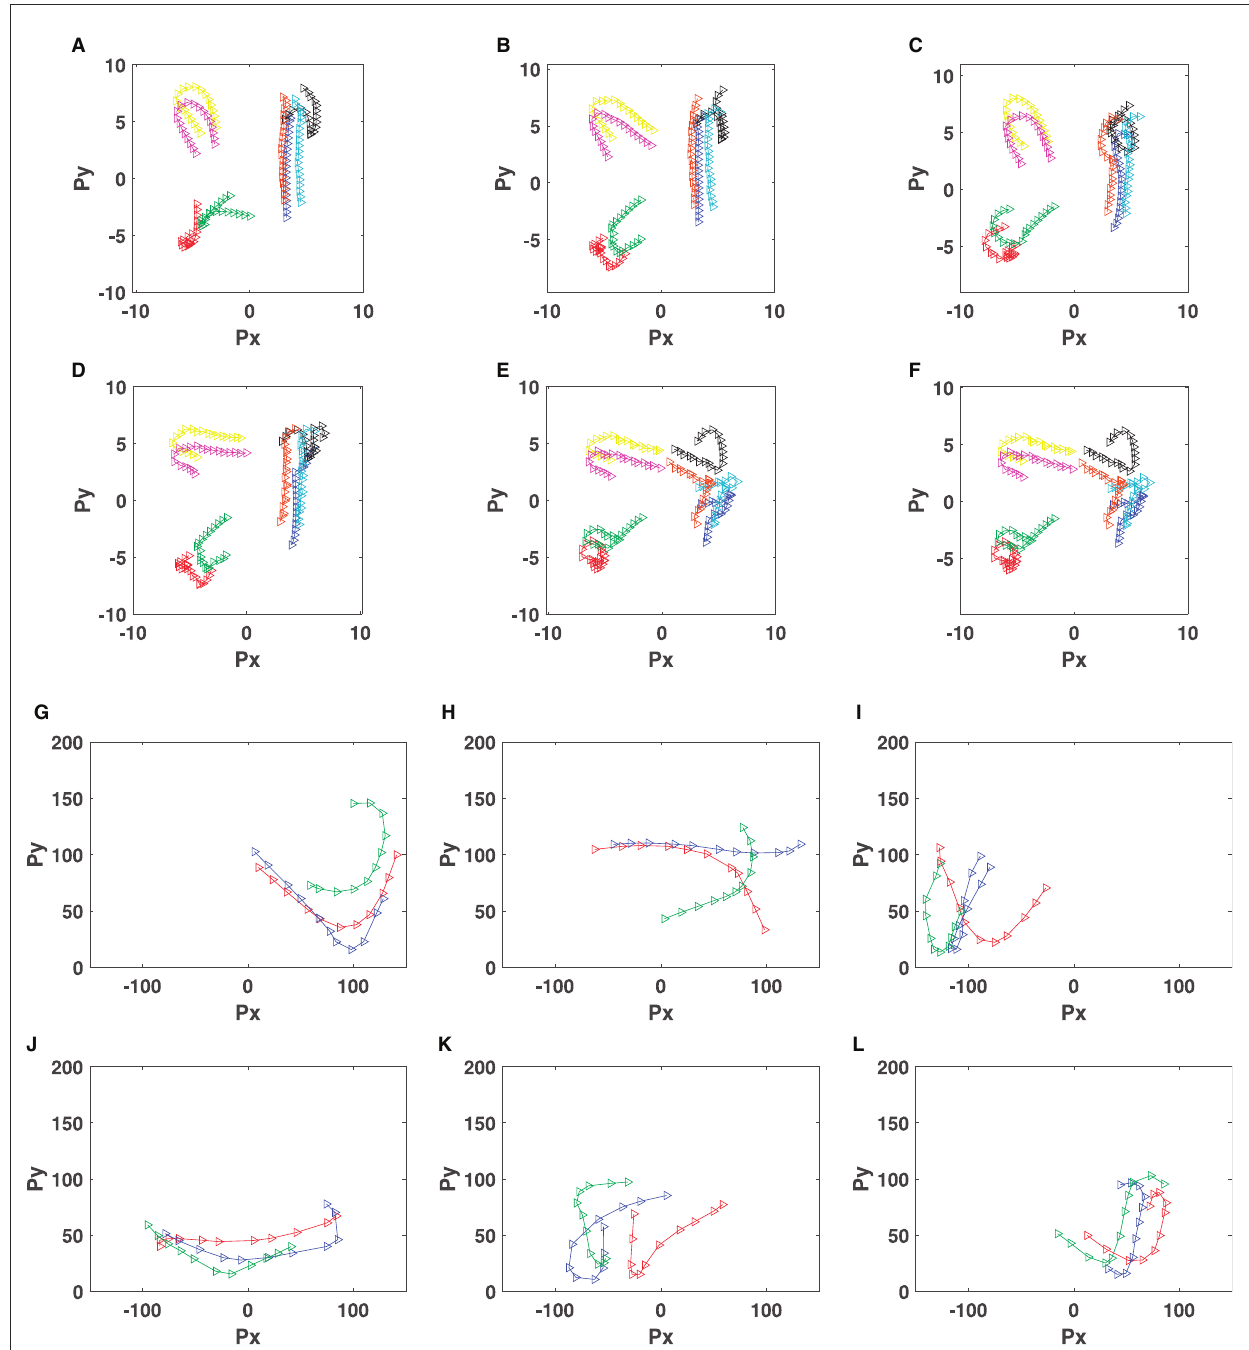
FIGURE11 Formation of automatic tuned behaviors in robots using CoMoT with iterative transfer learning approach (The robots keep the same formation during the movement and the blue arrow shows the direction of movement). (A) Tuned behavior for PR1. (B) Tuned behavior for PR2. (C) Tuned behavior for PR3. (D) Tuned behavior for PR4. (E) Tuned behavior for PR5. (F) Tuned behavior for PR6. (G) Tuned behavior for SR1. (H) Tuned behavior for SR2. (I) Tuned behavior for SR3. (J) Tuned behavior for SR4. (K) Tuned behavior for SR5. (L) Tuned behavior for